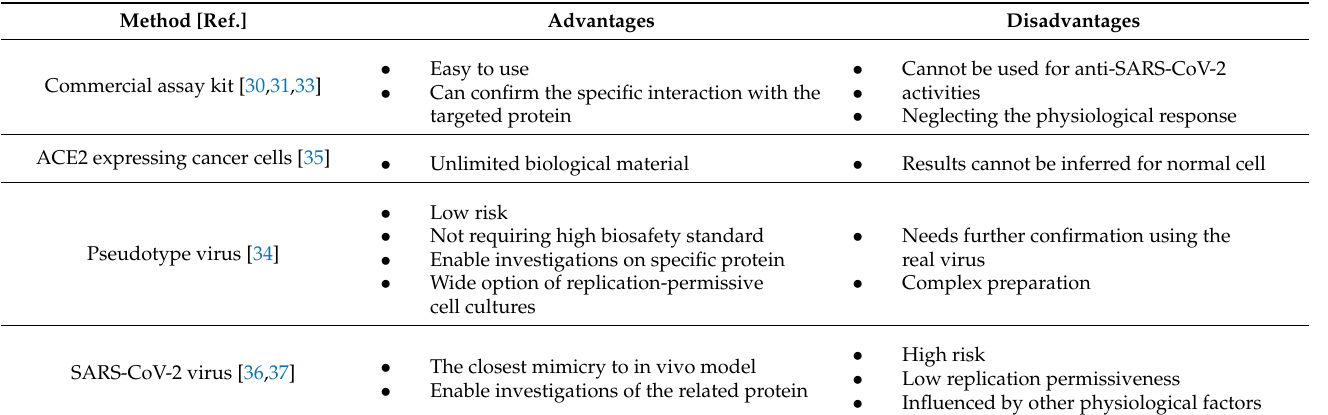
Table 6. Advantages and disadvantages of using various in vitro models as reported in the included